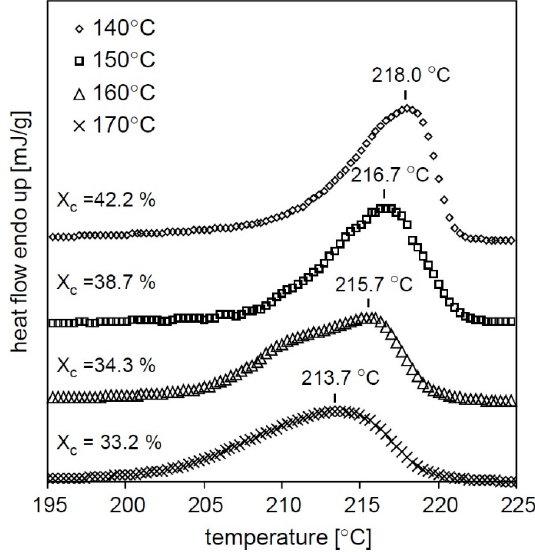
Figure 5. Degree of crystallinity and polymer melting point for various polymerization temperatures as measured by DSC (curves are shifted up for clarity). Reprinted from Reference [10], under open-access license.